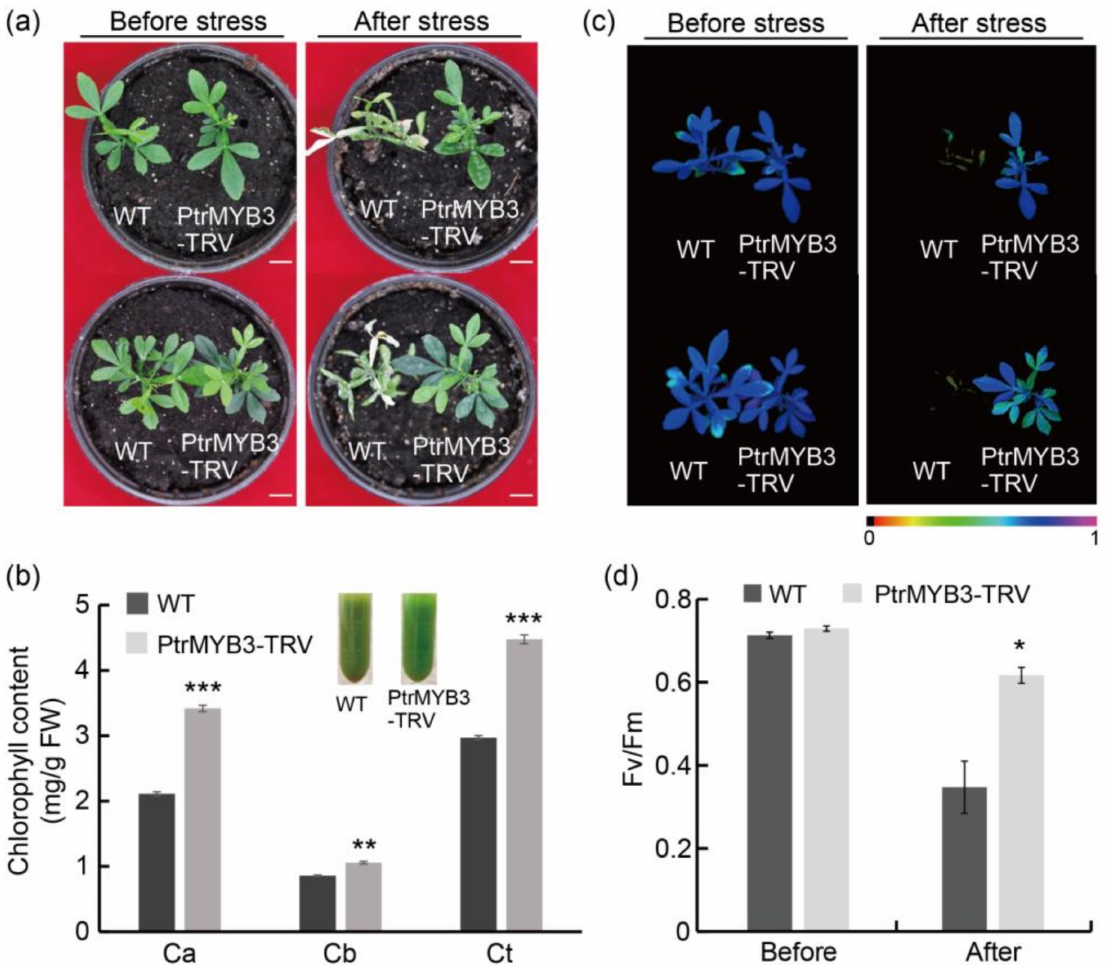
Figure 6. Silencing of PtrMYB3 in Poncirus trifoliata confers enhanced salt tolerance. ( a ) Phenotypes of WT and PtrMYB3- silenced plants (PtrMYB3-TRV) before and after salt stress. Bar = 1 cm. ( b ) Chlorophyll content (a, b and total) of WT and PtrMYB3- silenced plants after salt stress. The images above show the crude extract in WT and PtrMYB3-silenced plants. ( c , d ) The chlorophyll fluorescence imaging ( c ) and the Fv/Fm values ( d ) of WT and PtrMYB3-silenced plants before and after salt stress. Error bars indicate ± SE. Asterisks indicate significant differences between WT and PtrMYB3-silenced plants: p < 0.05 (*), p < 0.01 (**) and p < 0.001